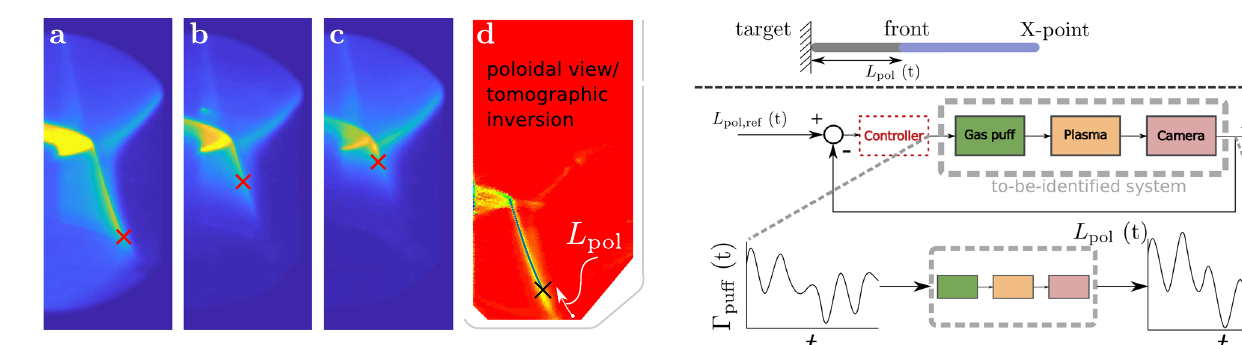
Fig. 3 Progressive cooling of the TCV divertor. C-III emission in TCV tokamak discharge #62154 for increasing radiative cooling of the divertor. The detected emission front is indicated in red. a Emission throughout the divertor leg: Emission front touches the wall. b The emission front creeps up toward X-point ( c ) Emission front close to the X-point. d Poloidal mapping of the divertor leg (blue) and emission front (black cross) in ( a ) in the TCV vacuum vessel with plasma emissivity from tomographic reconstruction in the background. The control parameter L pol , the arc length from emission front to divertor target, is highlighted in white.